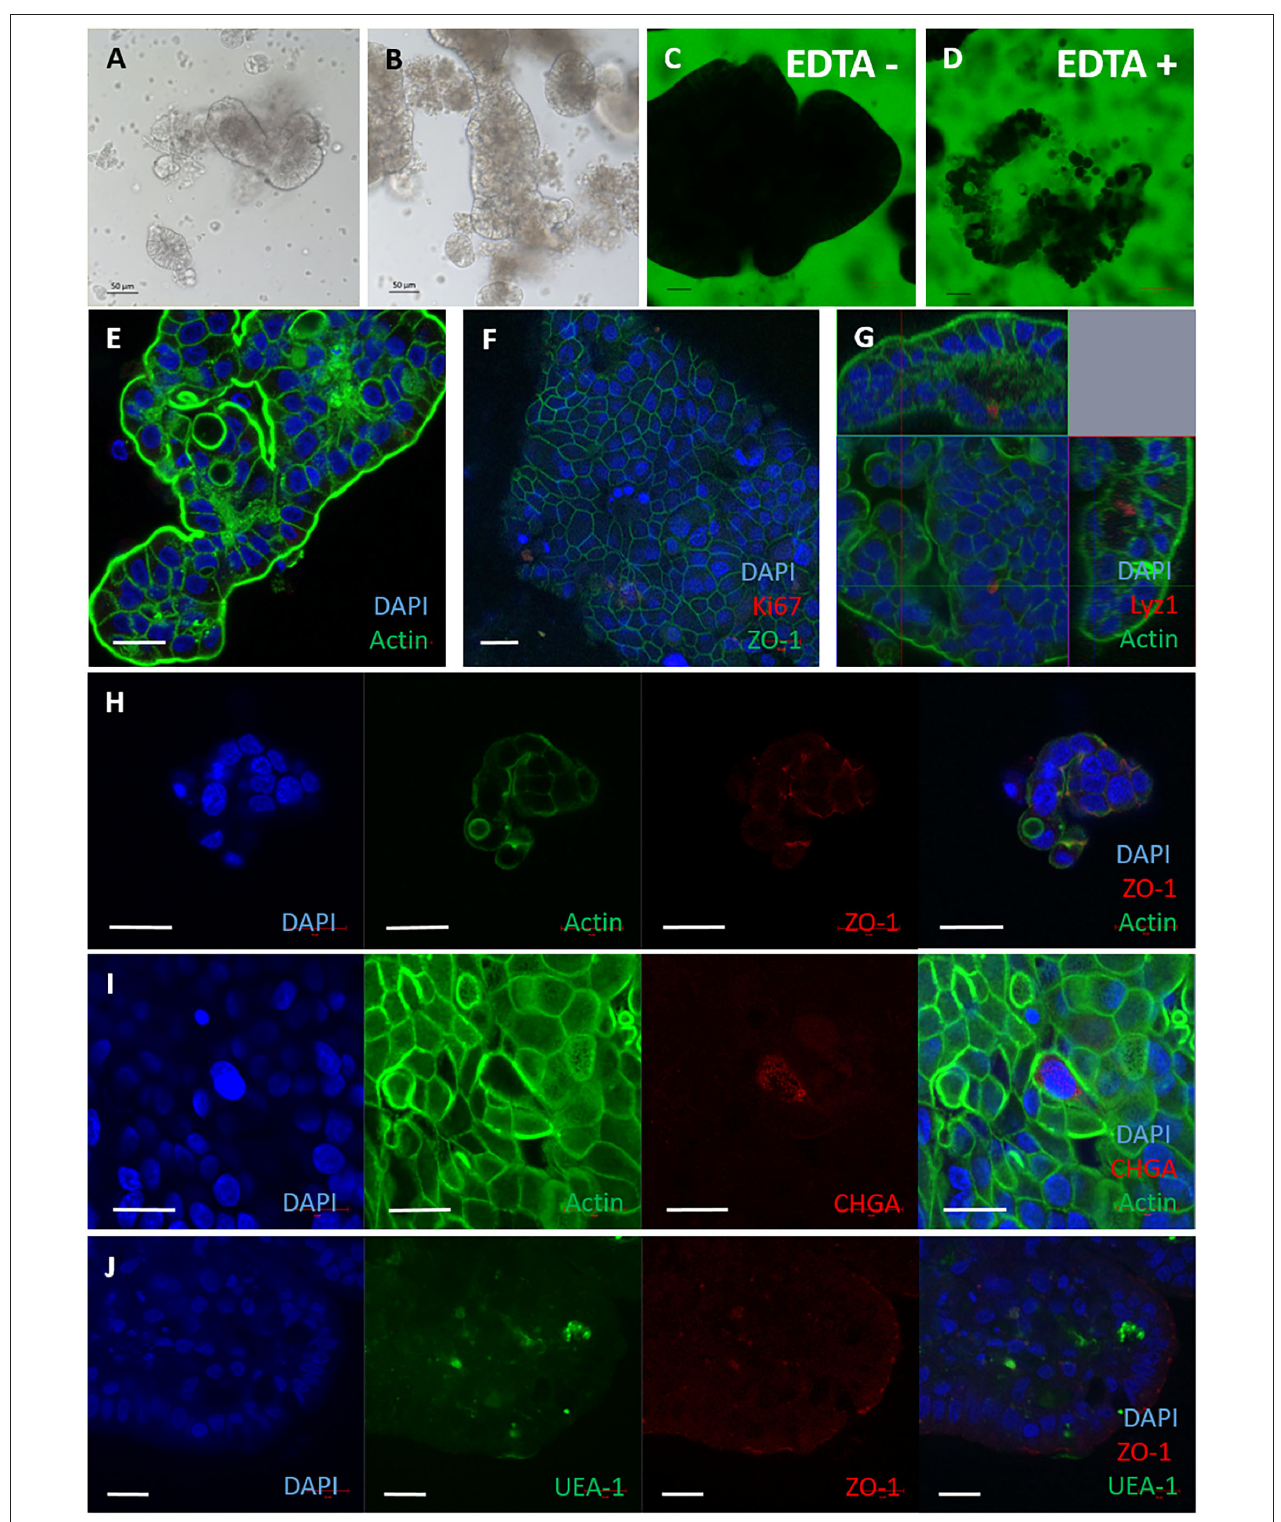
FIGURE 3 | Apical-out bovine enteroids show epithelial barrier integrity when established from freshly harvested intestinal crypts. Apical-out enteroids cultivated from freshly isolated intestinal crypts and cultured in suspension in Intesticult at 1 day (A) and 7 days (B) . Images are representative of enteroids derived from 3 independent animals. (C,D) Confocal images of bovine inside out enteroids (7 days of culture) immersed in FITC-dextran 4kDa showing epithelial barrier integrity in untreated (C)